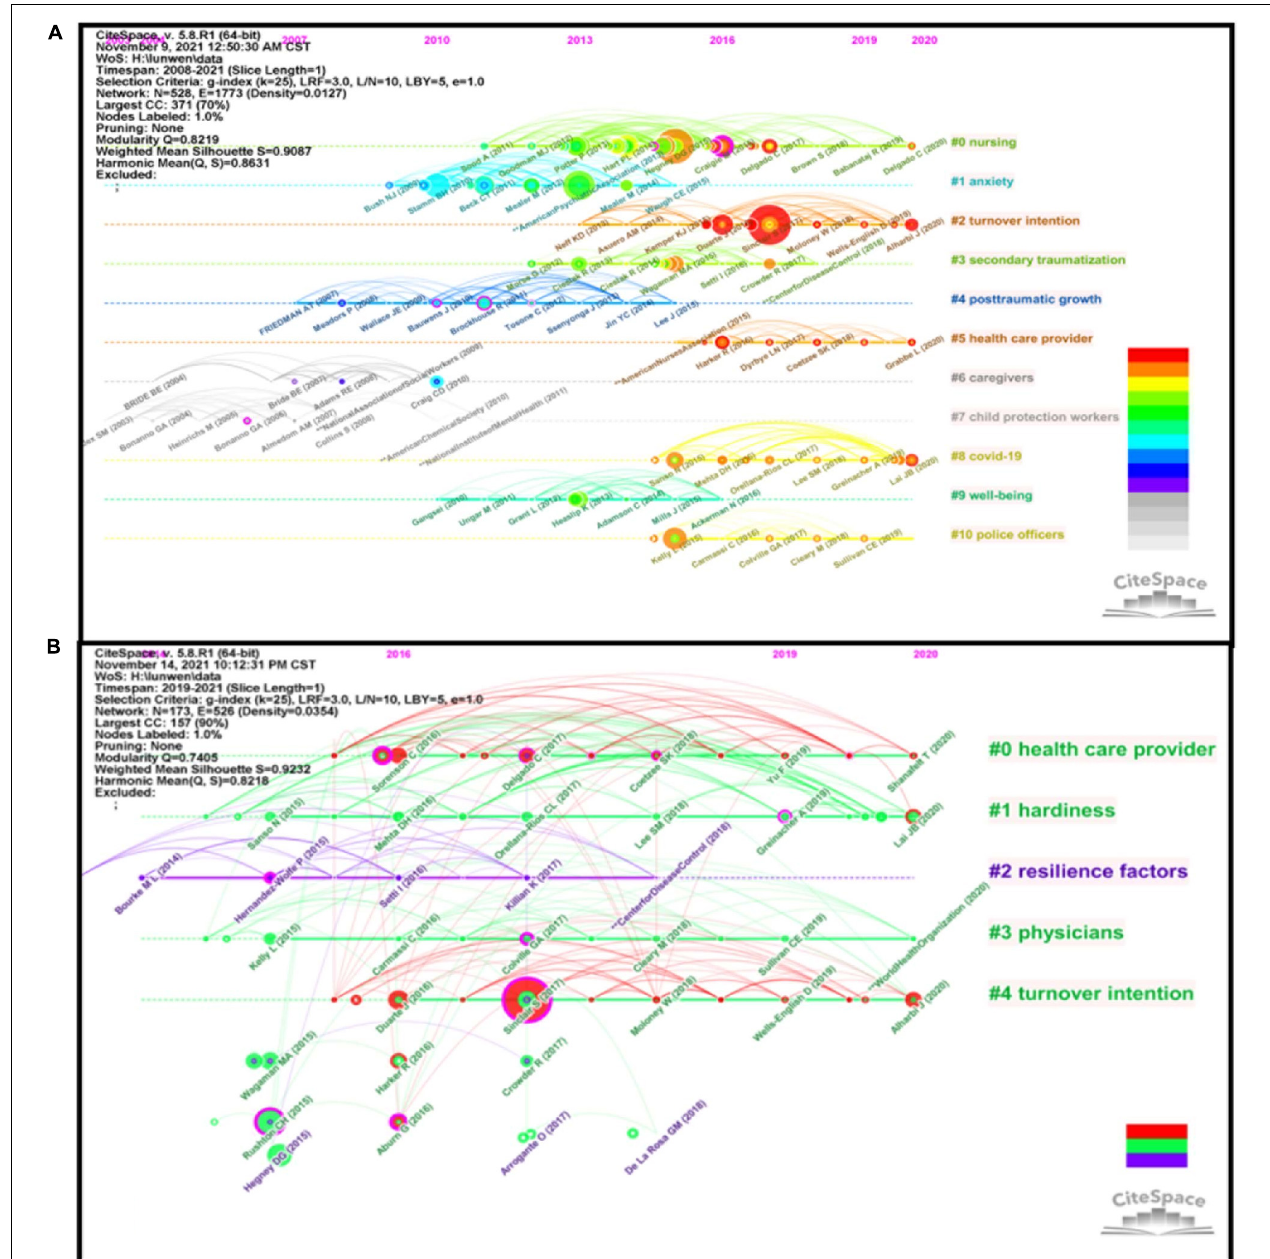
FIGURE 7 | The timeline view of research focused on CF and PR during 2008–2021 (A) and the COVID-19 pandemic (B) . In the timeline view plot, keywords on the same horizontal line belong to the right cluster. The colors of lines and keywords are corresponding to the colors of the time slice at the top.